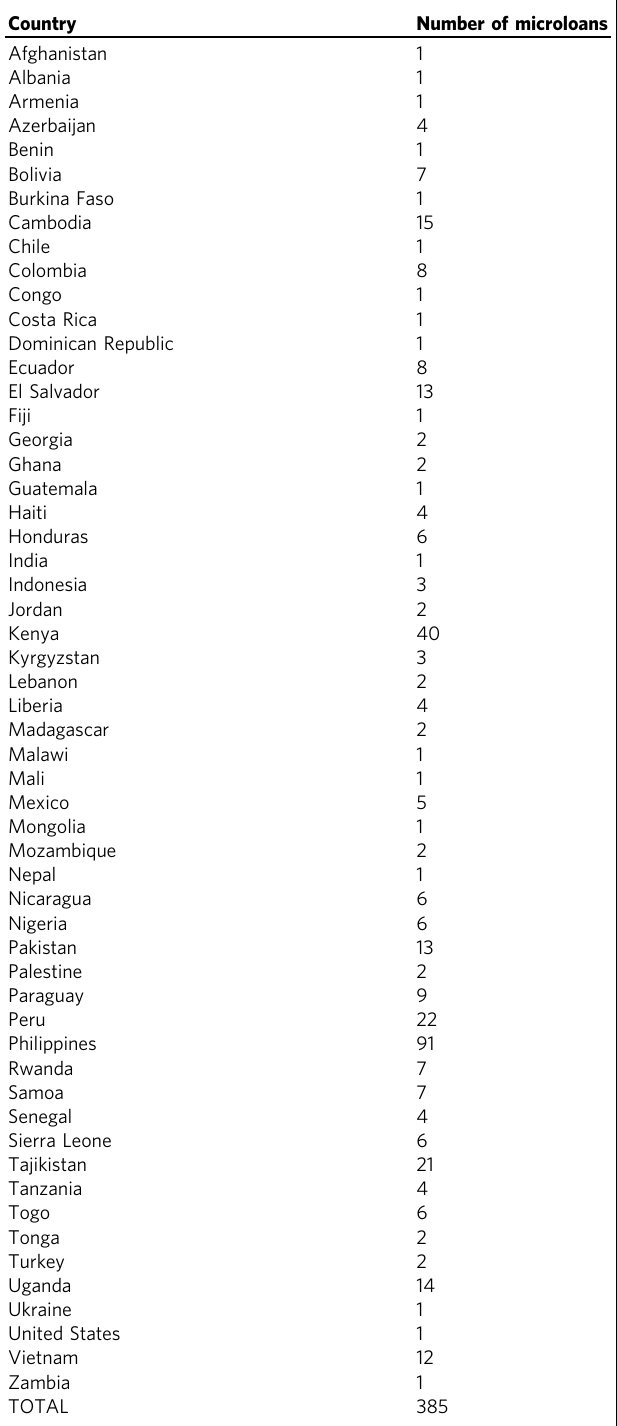
Table 2 Number of microloans in several countries. Source: Own